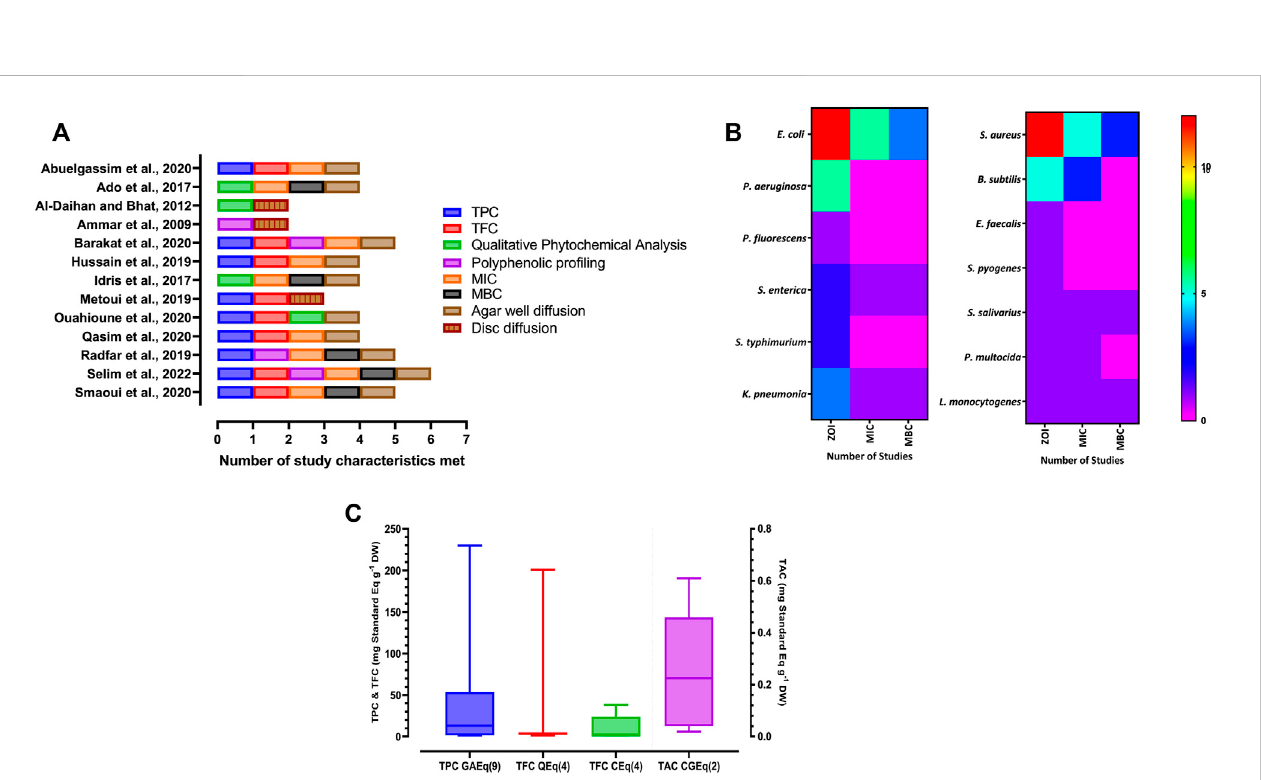
FIGURE 3 (A) Studycharacteristicsandanalysisvariations. (B) Heatmapofantibacterialassaycharacteristicsreportedforgram-negativeandgram-positivebacteria in included studies. (C) Boxplot of pooled median ± range of total phenolic content (TPC), total fl avanoid content (TFC) and total anthocyanin content (TAC) values reported in included studies (values in parentheses indicate number of